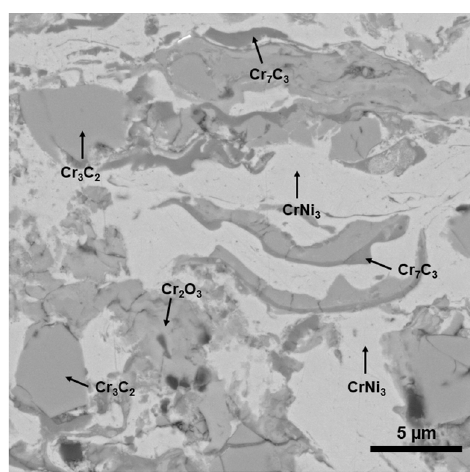
Figure 5. Cr 3 C 2 -NiCr coating microstructure.